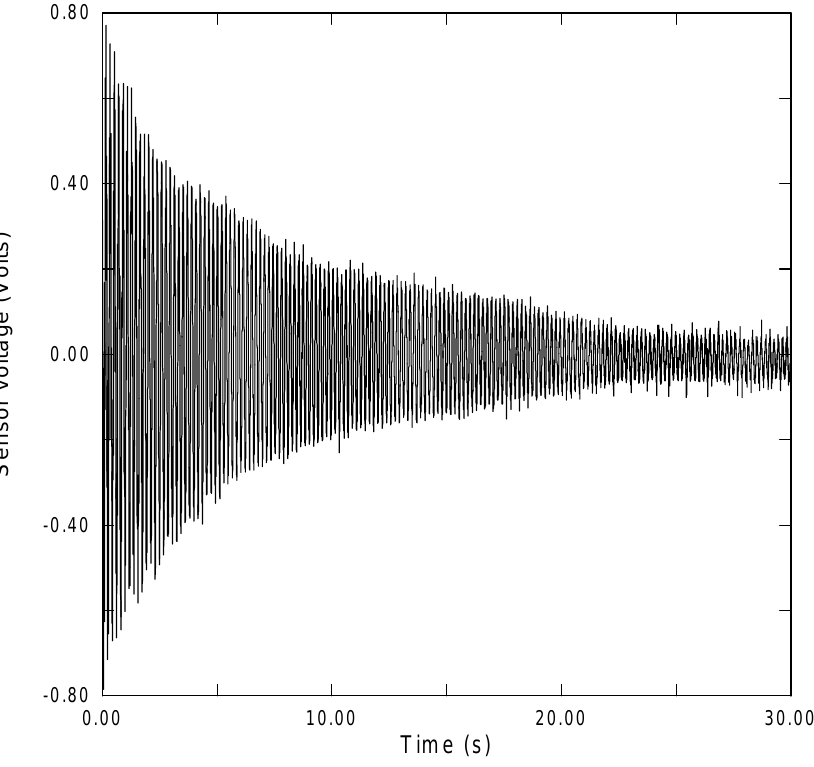
Fig. 13. Open-loop response of the experimental